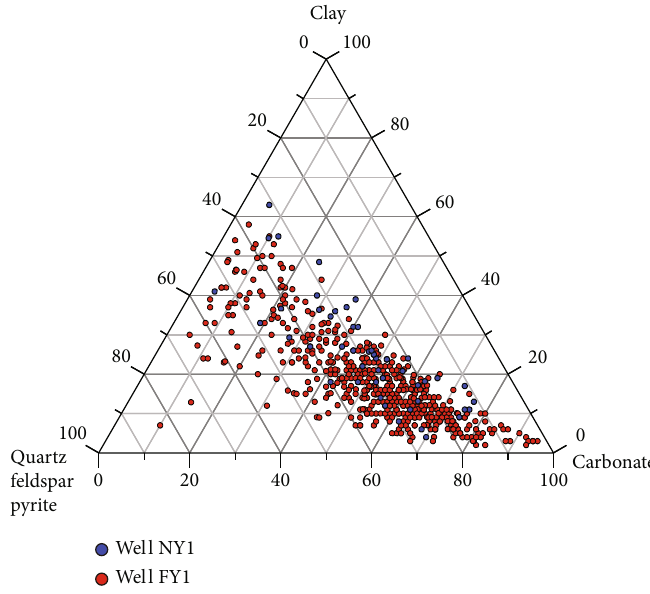
Figure 3: Ternary diagram of the mineral composition of the Shahejie Formation Es4s-Es3x shale. Table 2: The X-ray di ff raction data of samples from well NY1 and FY1